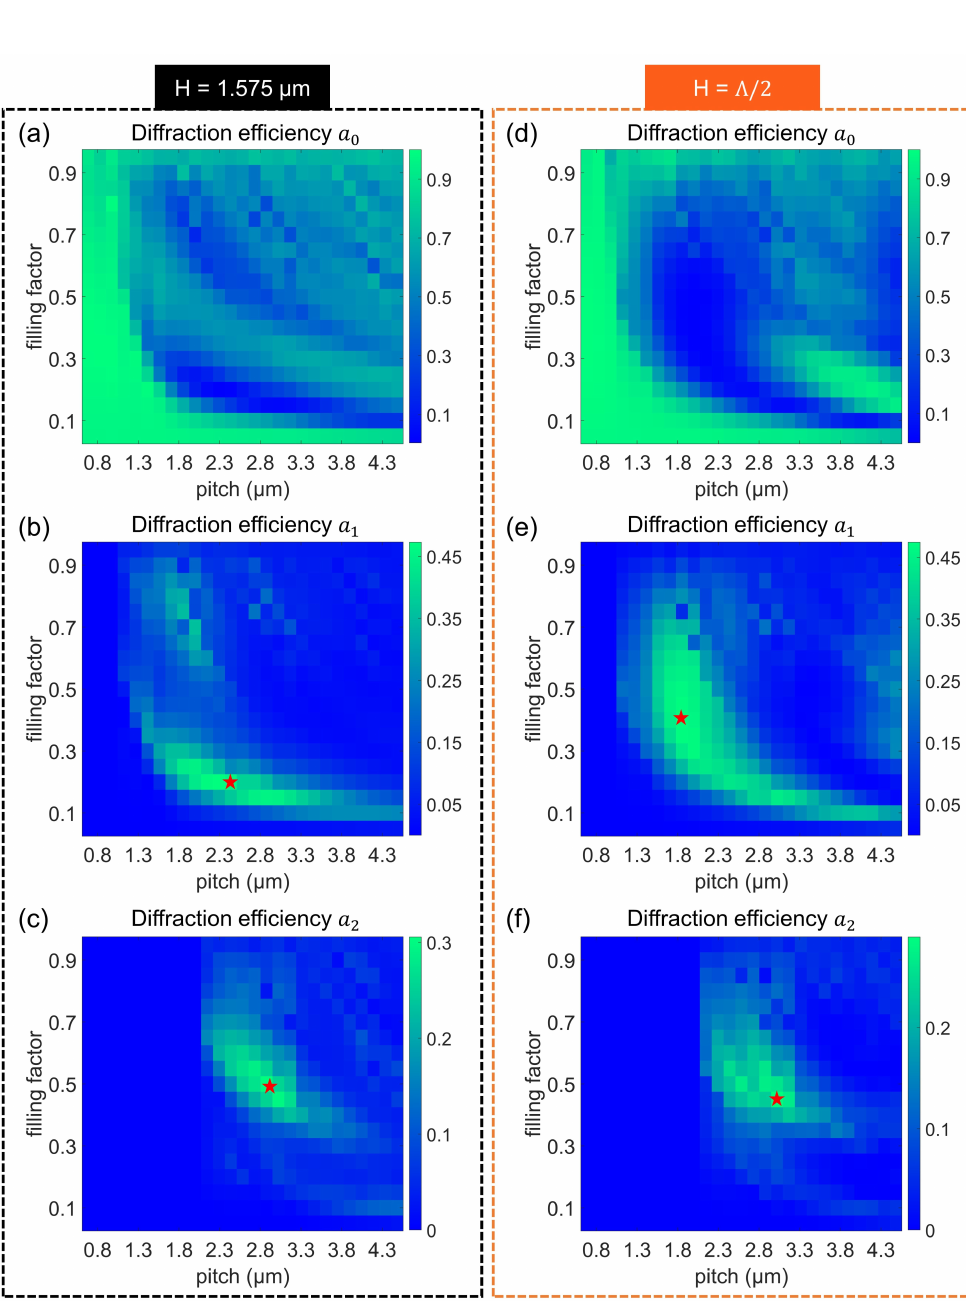
Figure 3. Diffraction efficiencies of binary gratings under normal incidences. Two vertical groups refer to the H at 1.575 µ m and a half pitch, respectively. Horizontal pairs ( a , d ), ( b , e ), and ( c , f ) correspond to grating efficiencies of a 0 , a 1 , and a 2 , separately. The red star-shaped markers in ( b , c , e , f ) are four gratings selected for the next